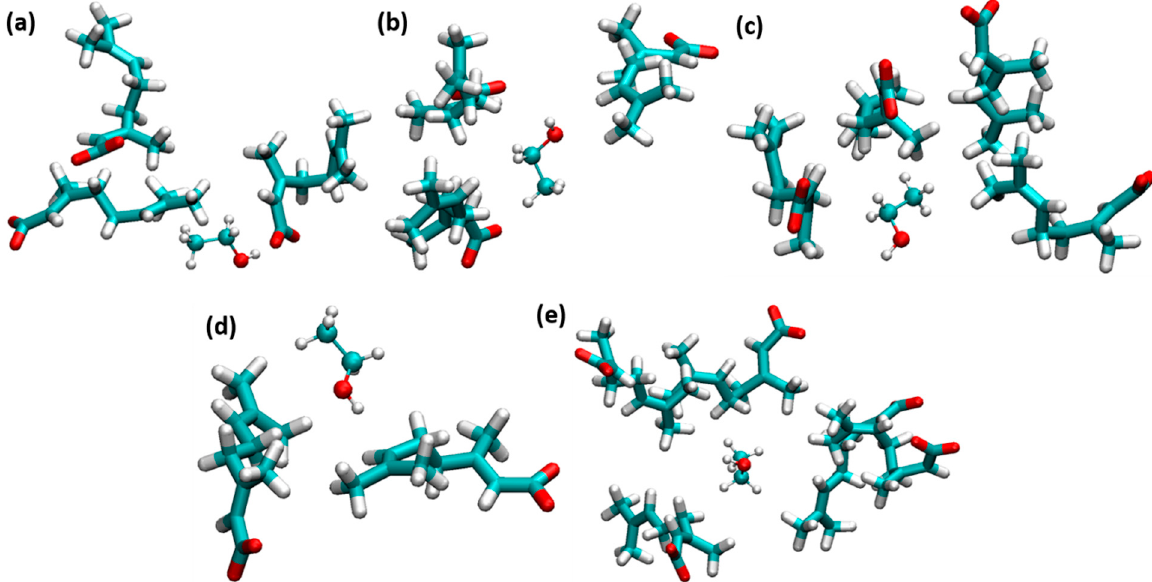
Figure 6. Ethanol molecules were trapped by geranate anions. ( a ) 0.10, ( b ) 0.20, ( c ) 0.40, ( d ) 0.60, and ( e ) 0.80 mole fractions of EtOH (licorice and ball-and-stick models indicate geranate and ethanol, respectively).